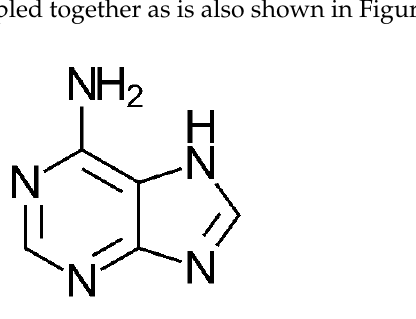
Figure 5. Structure of adenine. The numbering code is as follows: the N atom to the left of the NH 2 carrying C-atom is no 1, and following, anti clockwise around the six-membered ring so that the above-mentioned C-atom takes position no 6. Thereafter, from positions 5 and 4, around the five-membered ring one gets positions 7, 8, and 9. This means that the N-H group is number 9.